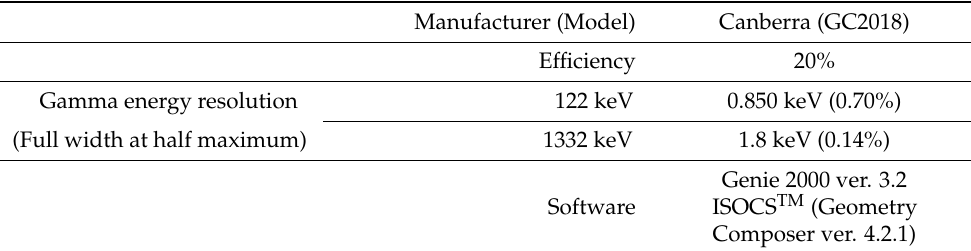
Table 1. Portable HPGe detector for gamma spectroscopy.